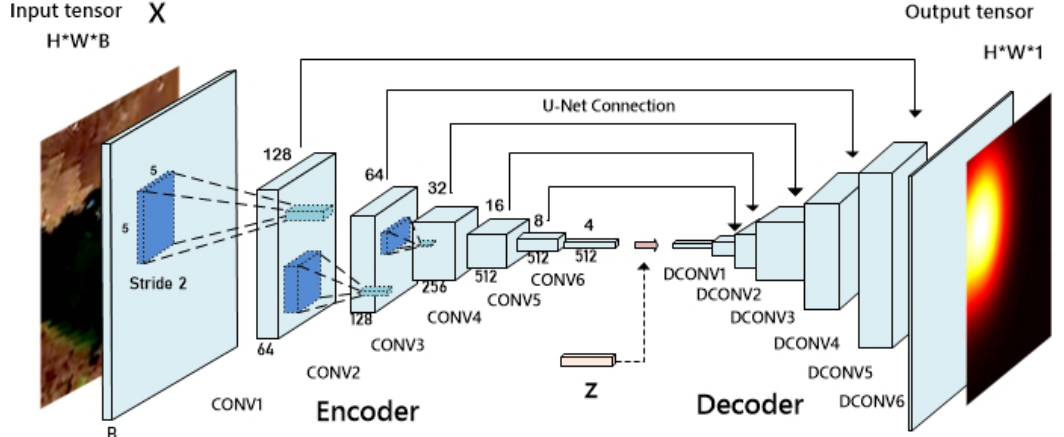
Figure 2. Architecture of the generator G in the adversarial framework. G generates samples G ( X , z ) from auxiliary information X and random noise z . “CONV/DCONV, stride = 2” denotes a convolutional/deconvolutional layer with two strides on each move. The number k under each tensor and the number d on the top stand for the size of the tensor is d × d × k .